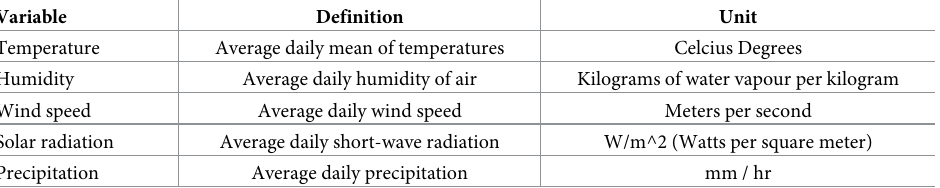
Table 2. Climatic variables.